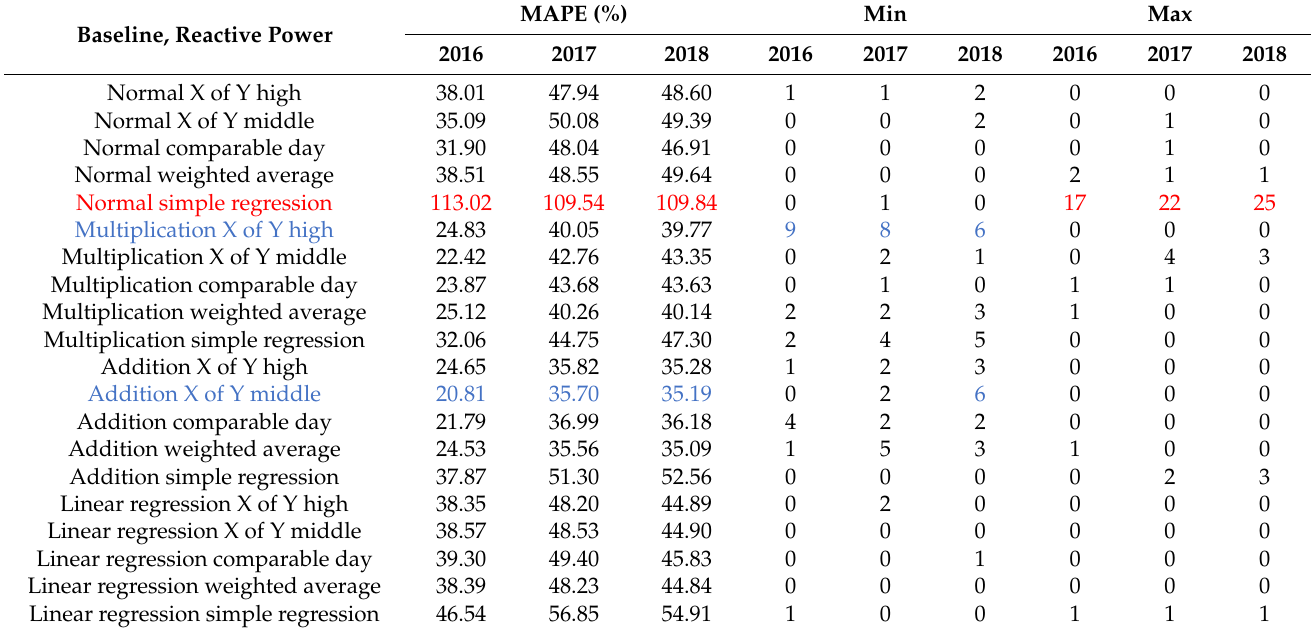
Table 5. Baseline, reactive power, MAPE (highlighted in red are the worst results, highlighted in blue are the best results). Baseline, Reactive